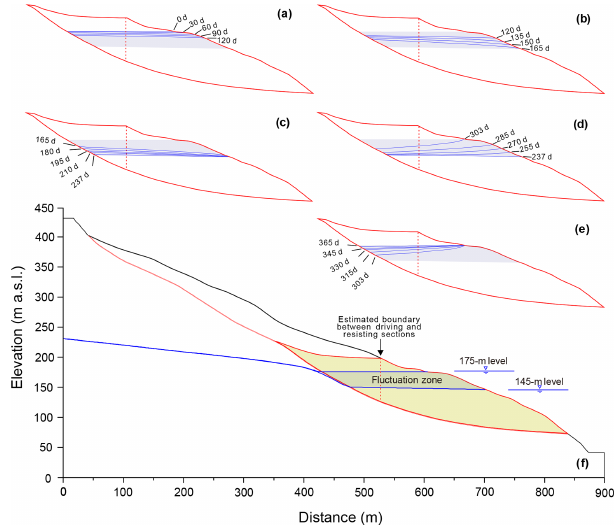
5.3 Scenario 3: trial impoundment at 175 m a.s.l. During 2008 to 2014 the reservoir level periodically fluctu- ated between 145 and 175 m a.s.l. (Stage 3), in accordance with a generalized annual water level variation curve that consists of five phases (Fig. 13b). During the slow drawdown period, the groundwater stor- age in the driving section is reduced by an amount that ap- proximately matches the reduction in the resisting section (Fig. 16a), so the effect of buoyancy forces on slope